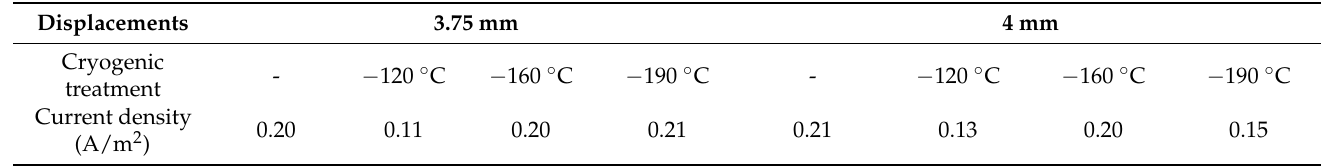
Table 5. Current density of each process sample under strain 3.75 mm and 4